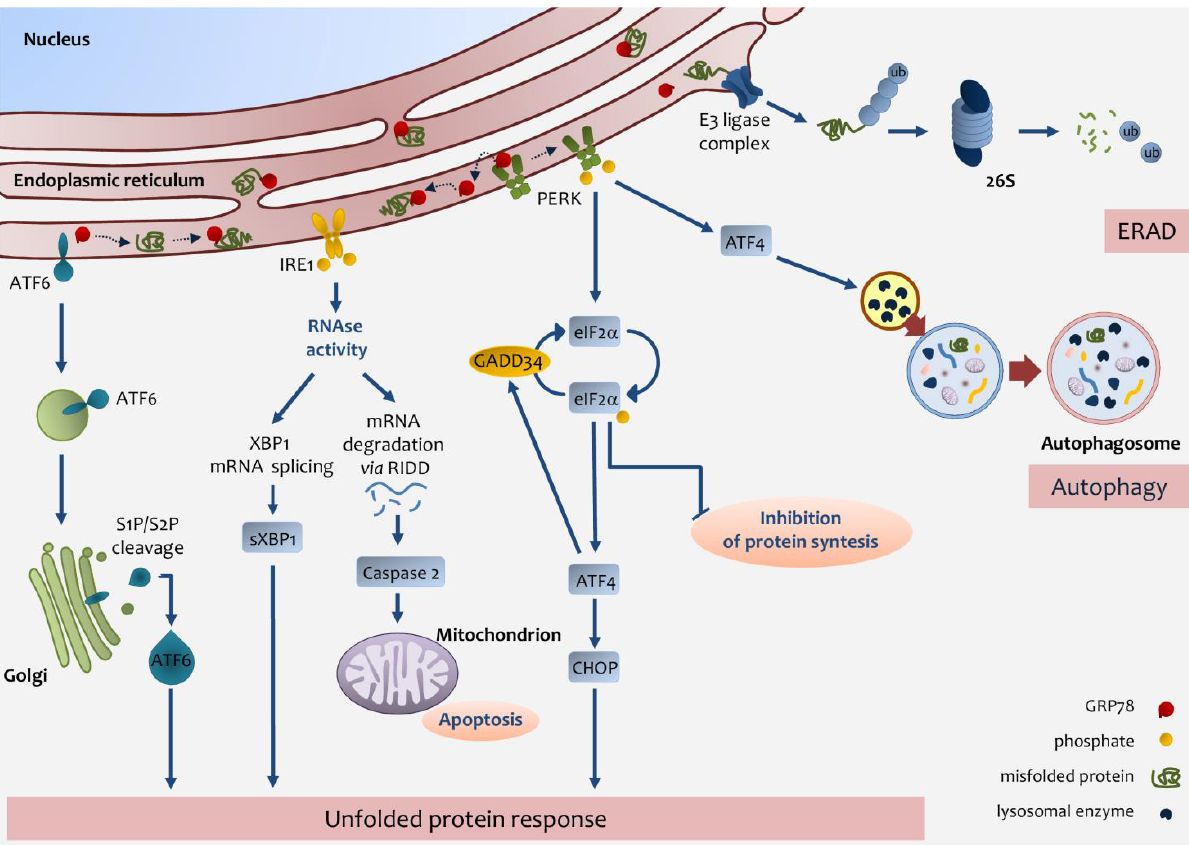
FIGURE 2: Endoplasmic reticulum (ER) stress pathways . ER stress occurs through the accumulation of misfolded proteins in the ER lumen. The role of the UPR is to re-establish ER homeostasis by reducing de novo protein synthesis and improving the folding and clearance capac- ity of the ER. The first mechanism against ER stress is ERAD, by which misfolded proteins are translocated back to the cytosol, ubiquitylated and degraded by the proteasome. When the level of misfolded proteins is too high, the cell activates UPR consisting in the activation of three transmembrane pathways. The main effectors are PERK, IRE1 and ATF6. Effectors activation is initiated by the removal of GRP78 allowing the translocation of the latter from the ER membrane to the ER lumen where it associates with unfolded proteins. eIF2α phos- phorylation inhibits protein translation except for ATF4 which induces the expression of factors involved in antioxidant defence, amino acid metabolism, autophagy and apoptosis, such as CHOP. ATF4 also induces the expression of GADD34, which expression enables the dephosphorylation of eIF2α and the re-initiation of translation. PERK-mediated induction of ATF4, can also promote the expression of key autophagy-related proteins, which are needed for autophagosome formation. Once activated, IRE1 promotes the splicing of XBP1 mRNA, which is then translated into the active sXBP1, which transactivates the expression of components related to protein folding, ERAD and protein quality control. IRE1 also promotes the degradation of RNAs localized in the ER vicinity by regulated IRE1-dependent decay (RIDD), which induces caspase-2 and mitochondrial apoptosis. Upon GRP78 release, ATF6 is transferred to the Golgi apparatus as inactive precur- sors and cleaved by membrane-bound site-1 (S1P) and site-2 (S2P) proteases into an active form, which induces the expression of chaper- ones and UPR components. IRE1-mediated activation of XBP1 as well as ATF6 activation induces the expression of chaperones and UPR